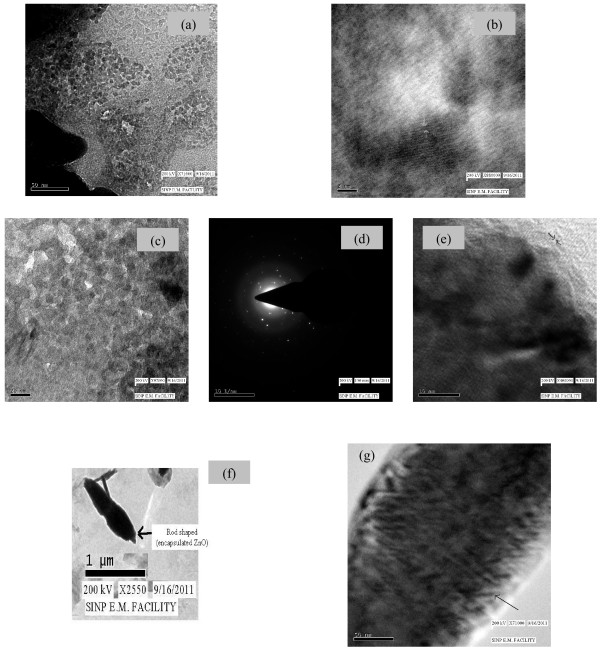
TEM images for structural morphology of (a) pure ZnO sample and (b) the corresponding fringe patterns; (c) Z1.3sample and the corresponding (d) SAED and (e) fringe pattern; (f) Z4.8sample and (g) the corresponding fringe pattern of rod-like structure.